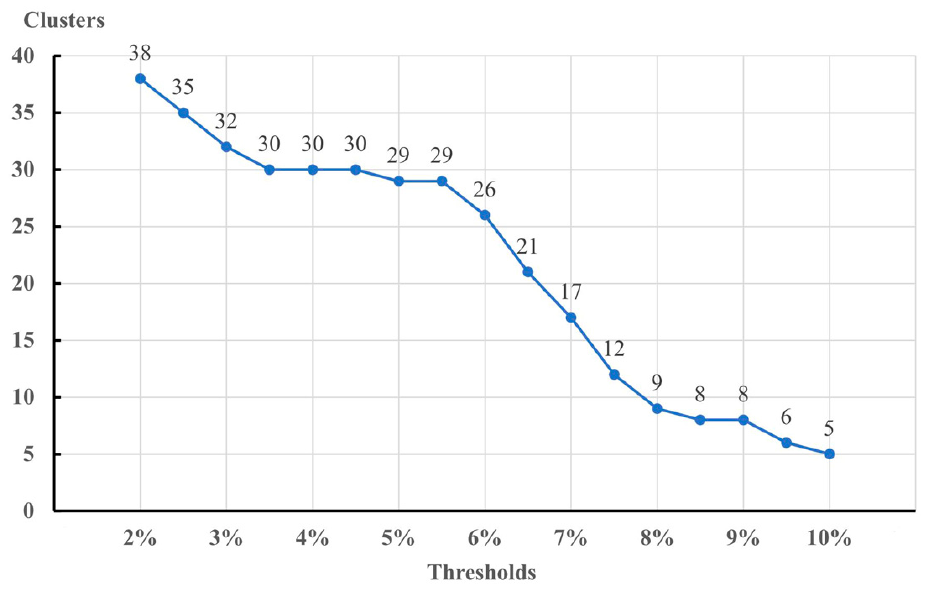
Figure 3. Number of OTUs based on DNA barcodes of Microtendipes using pre-threshold clustering at different thresholds.